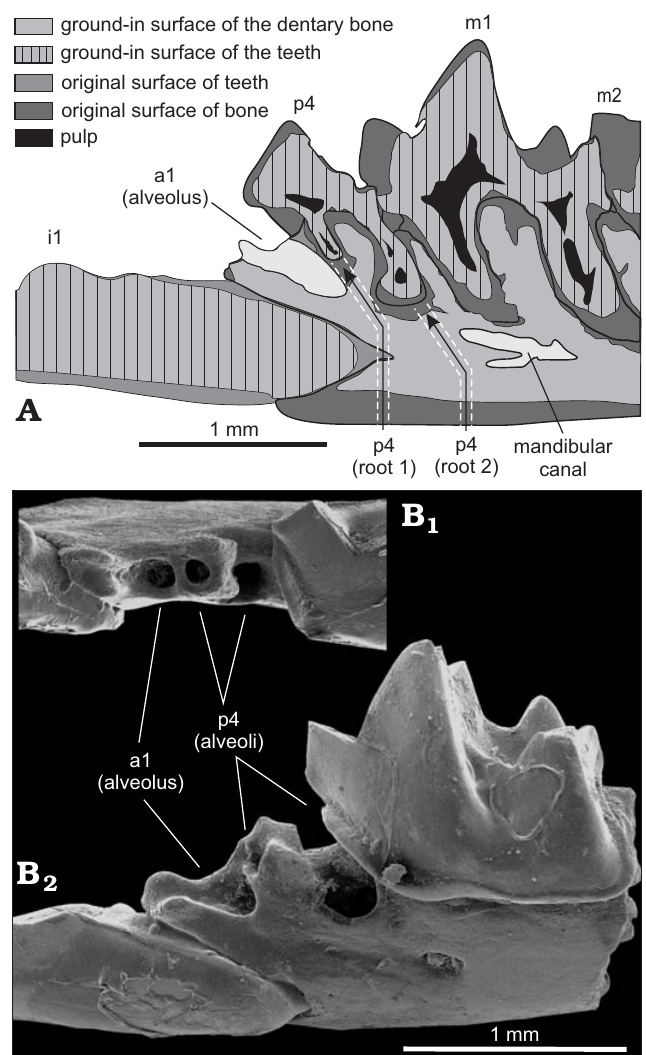
Fig. 7. Number and relative position of the lower antemolar alveoli of cro- cidosoricine shrew Shargainosorex angustirostris gen. et sp. nov. from mid- dle Miocene Sharga 2 locality, Mongolia. A . ZISP 104324/1098 (paratype), longitudinal (parasagittal) section of the left dentary fragment in buccal view. B . ZISP 104324/1002 (paratype), right dentary fragment (mirrored) in occlusal (B 1 ) and buccal (B 2 )